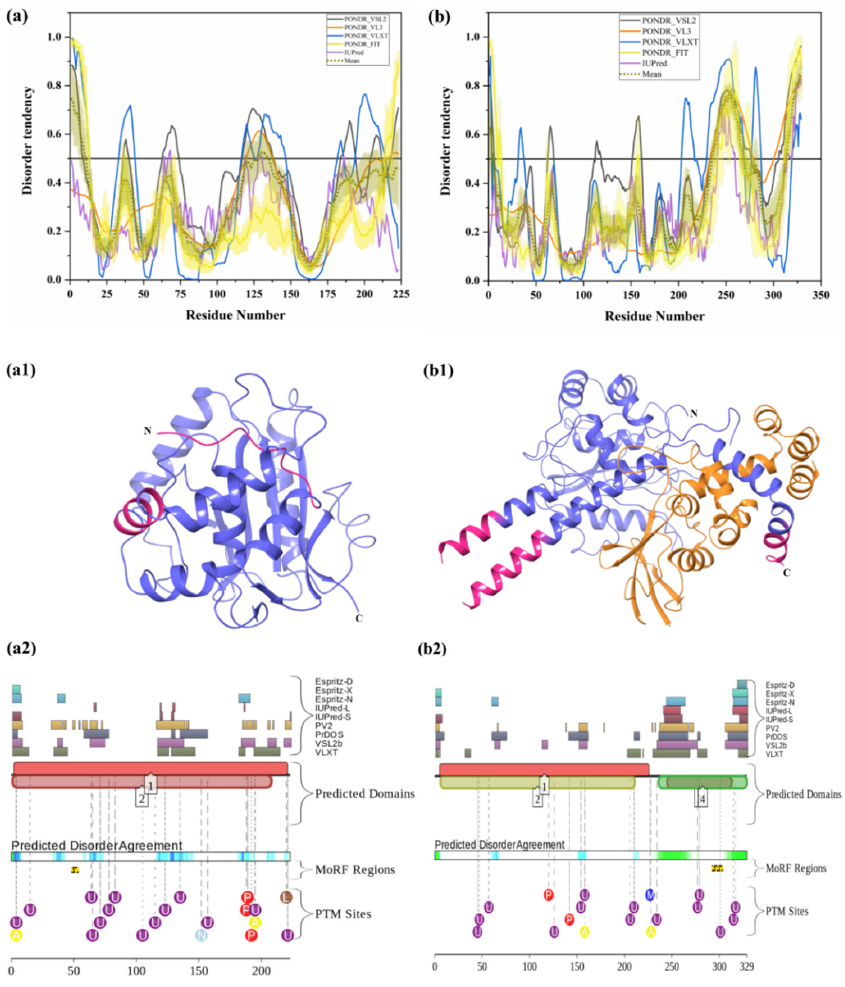
Figure 7. Intrinsic disorder predisposition and structural characterization of UCHL1 and UCHL5. ( a ) Disorder profile of human UCHL1 (UniProt ID: P09936) ( b ) Disorder profile of human UCHL5 (UniProt ID: Q9Y5K5) ( a1 ) Crystal structure of UCHL1 (PDB ID: 4JKJ). ( b1 ) Crystal structure of UCHL5 (PDB ID: 4UEL). In ( a , b ), intrinsic disorder profiles obtained from disorder predictors, such as PONDR ® VSL2, PONDR ® VL3, PONDR ® VLXT, PONDR ® FIT and IUPred, are depicted by black, orange, blue, yellow, and purple lines respectively. Mean disorder profile, calculated from the average of five predictor-specific per-residue disorder profiles, is represented by the olive color. Predicted disorder scores above 0.5 are considered disordered residues/regions. The light-olive shadow around the mean curve represents the error distribution for the mean. The light-yellow shadow around the PONDR ® FIT curve shows the error distribution for PONDR ® FIT. In ( a1 , b1 ), UCHL1 and UCHL5 are represented by faded blue color; in Plot ( b1 ), the DEUBAD domain of the RPN13 protein and Ub in complex with UCHL5 are shown in orange color. Disordered residues are shown in salmon pink color. In ( a2 , b2 ), the functional disorder profile of UCHL1 and UCHL5 proteins using the D2P2 server have been